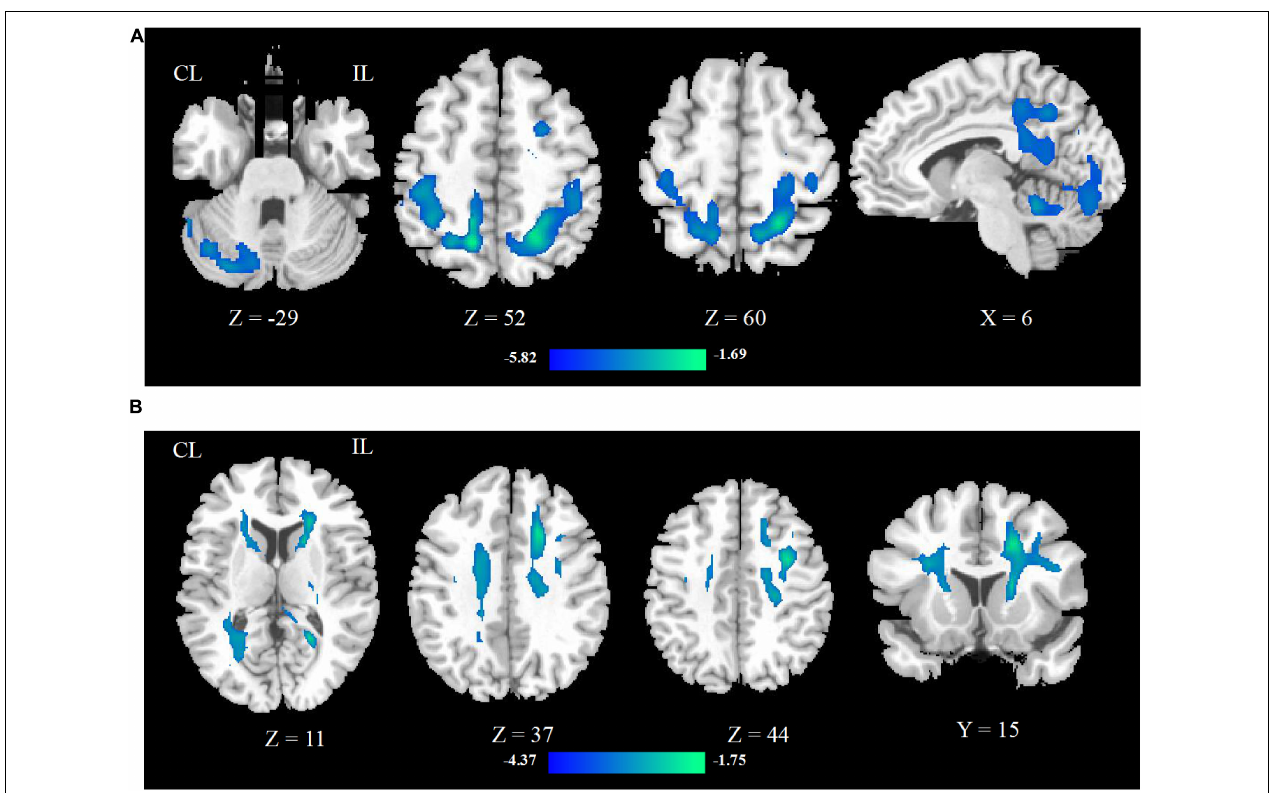
FIGURE 1 | The CBF (A) and FA (B) changed between stroke patients and HCs. The blue color represents the decreased areas of CBF and FA values. CL, contralesional; IL, ipsilesional; HCs, healthy controls.